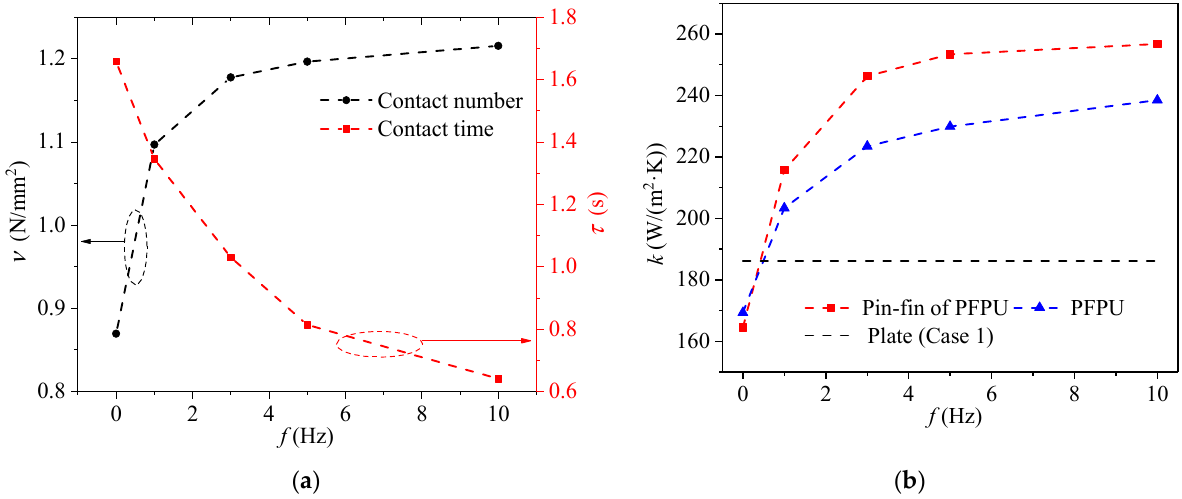
Figure 8. ( a ) Variations of the time-average unit area particle contact number of pin-fin and the time-average contact time of particles with pin-fin at different frequencies ( OD = Y, A m = 0.25 D ); and ( b ) variations of heat transfer coefficient of particles flow around the PFPU at different frequencies ( OD = Y, A m = 0.25 D ).